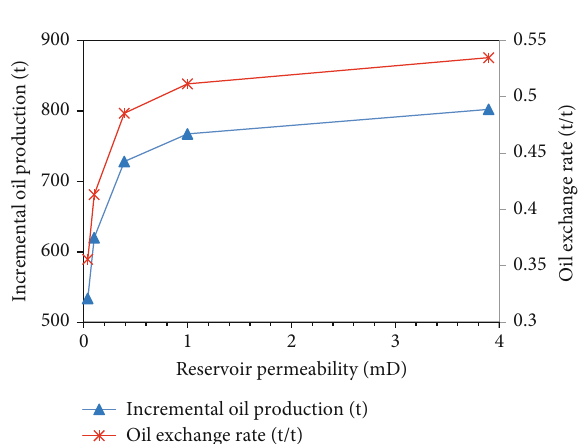
Figure 8: Variations of the incremental oil production and oil exchange rate at di ff erent reservoir